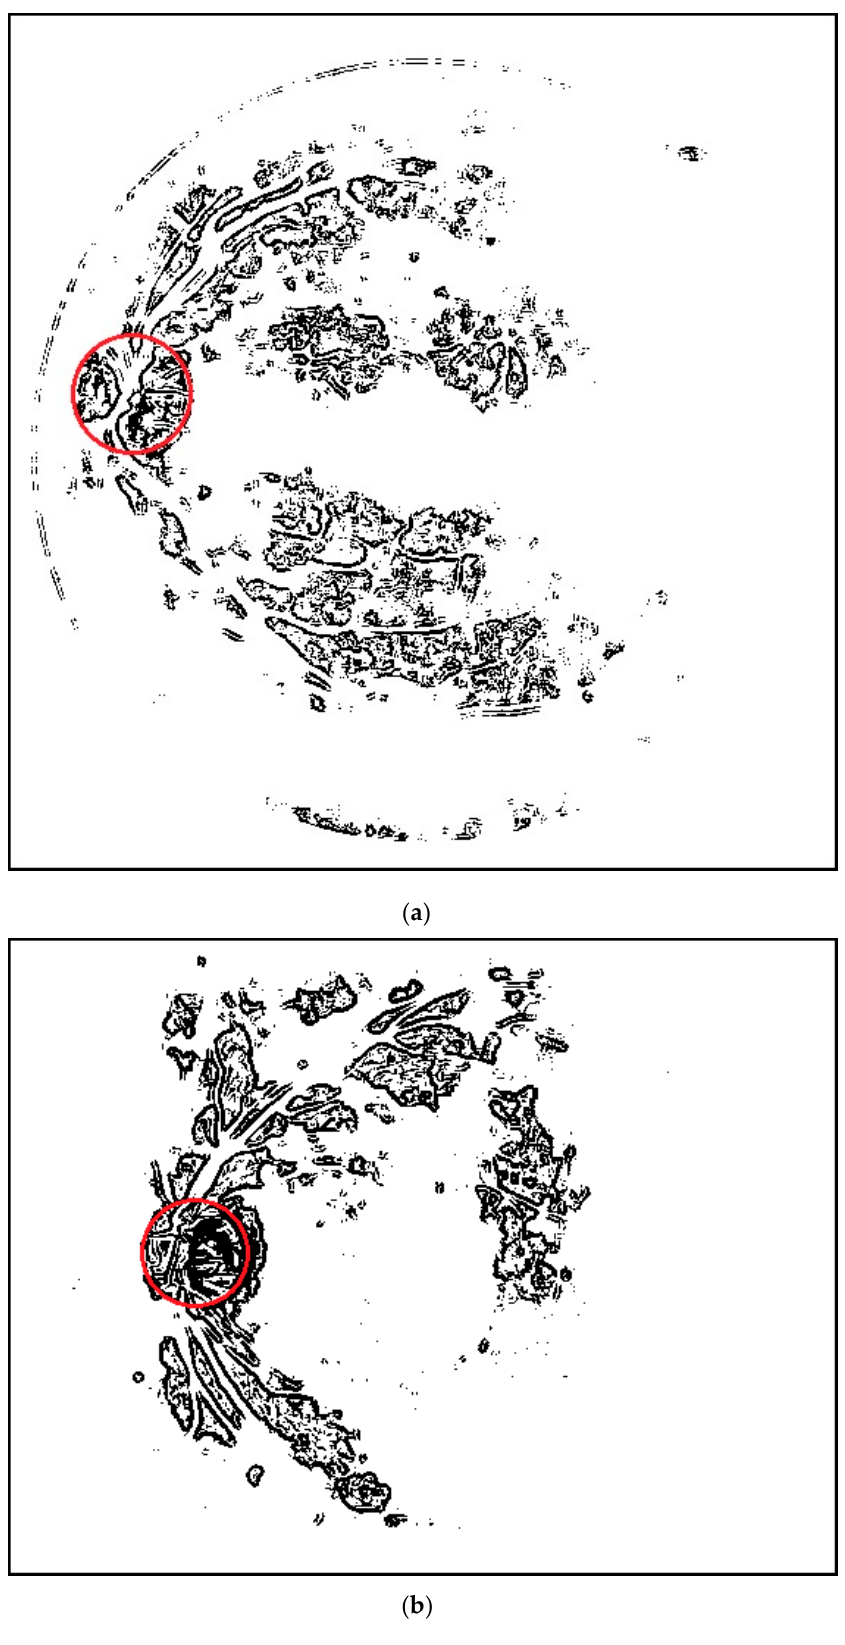
Figure 9. Circular Hough transform applied after edge detection. ( a ) is a healthy retinal image; ( b ) is a diseased retinal image.